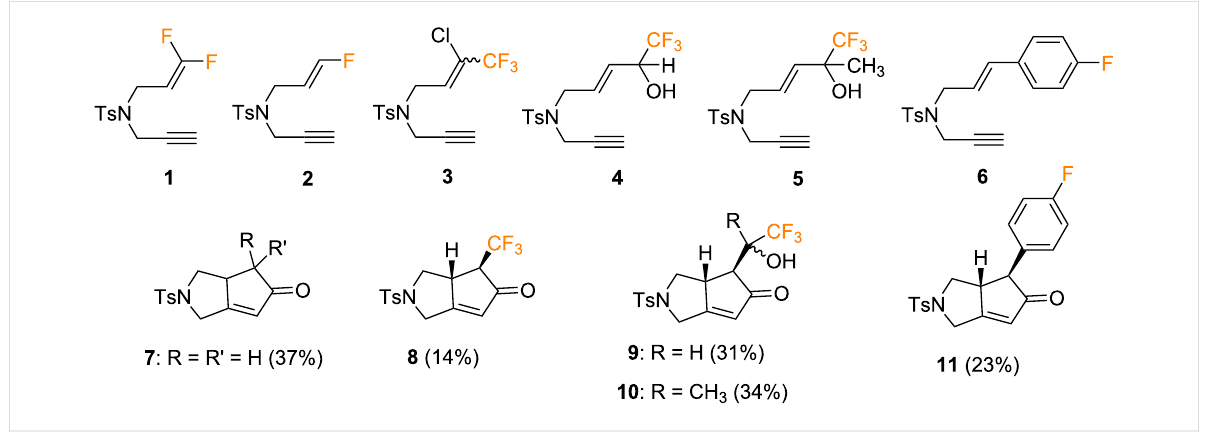
Scheme 6: Pauson–Khand reaction of fluoroolefinic enynes reported by the group of Ishizaki